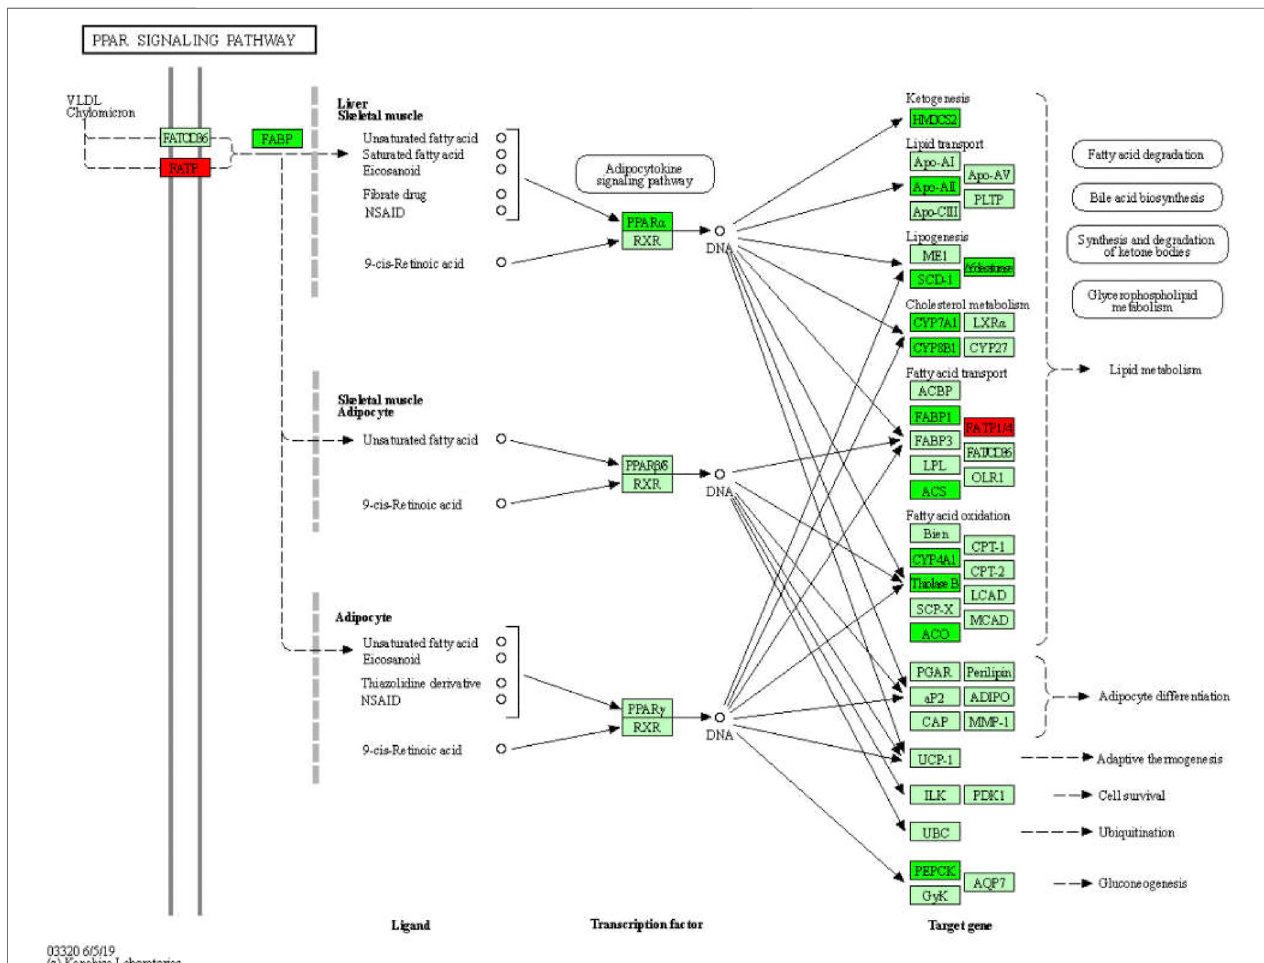
FIGURE 8 | Signi fi cantly enriched KEGG pathways in PPAR signaling pathway.